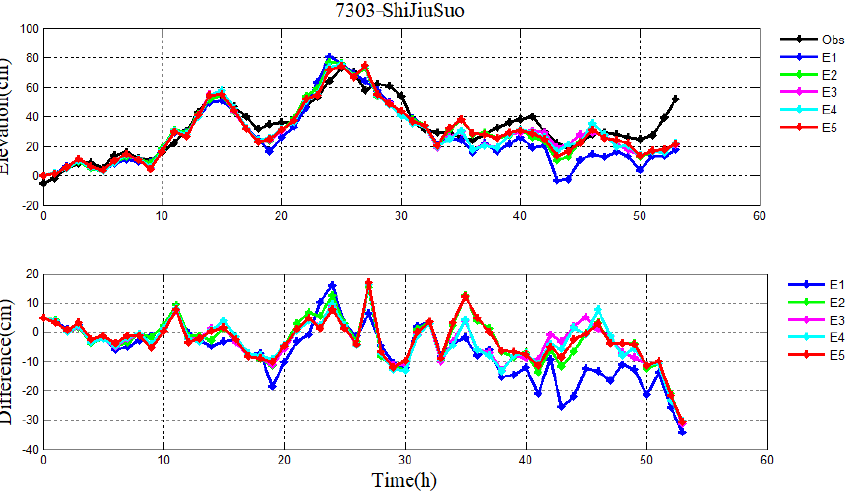
Figure 5. Pure storm surge levels in experiments E1 − E5, observation (black line) ( top ), and their differences ( bottom ) during Typhoon 7303 at ShiJiuSuo station.